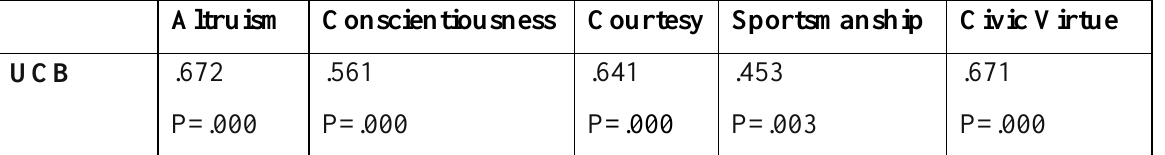
.641 .453 P=.000 P=.003